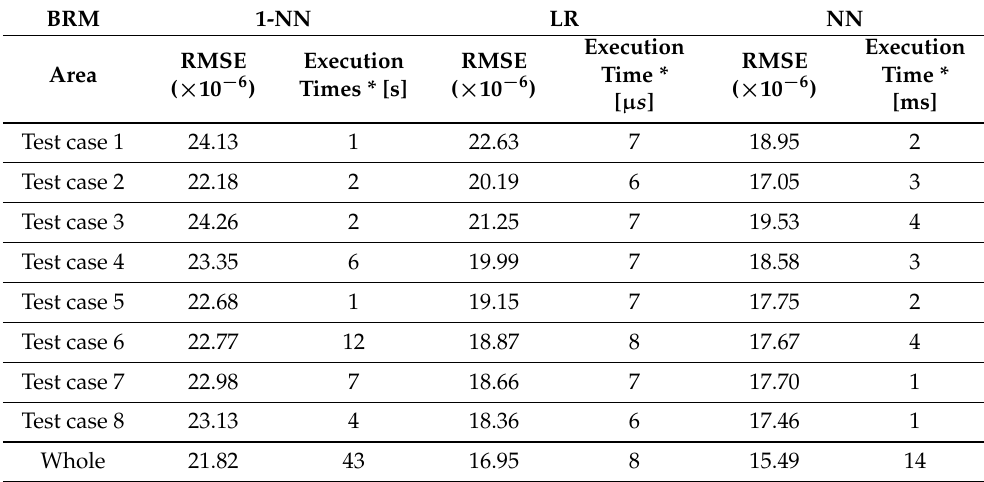
Table 3. Comparison of RMSE [mol/m 2 ] and execution times on a test dataset, achieved by 1-NN, NN, and LR, on the selected test cases.